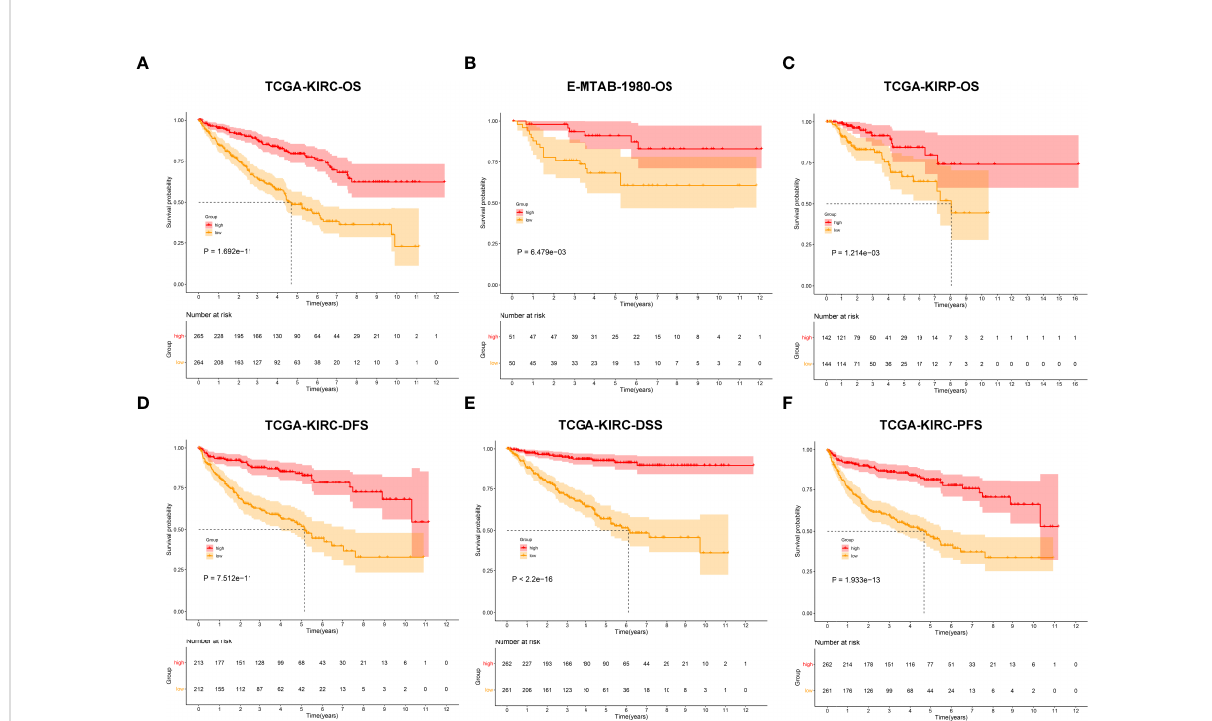
FIGURE 6 Analysis of the prognostic implication of the agingScore. (A – C) Kaplan – Meier analysis for OS between the high and low agingScore groups in the (A) TCGA-KIRC cohort, (B) E-MTAB-1980 cohort, and (C) TCGA-KIRP cohort. ( D – F ) Kaplan – Meier analysis for (D) DFS, (E) DSS, and (F) PFS between the high and low agingScore groups in the TCGA-KIRC